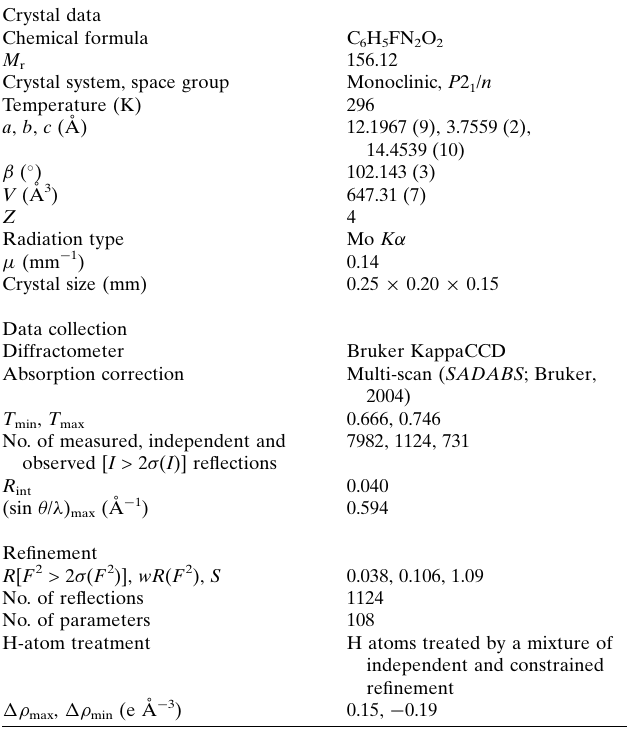
Table 2 Experimental details.